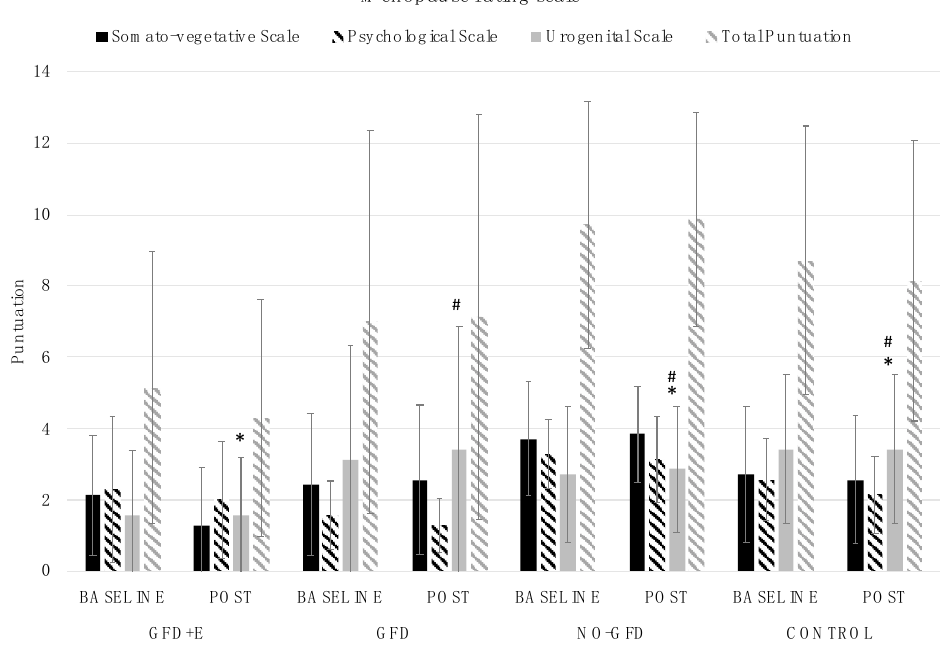
Figure 3. Descriptive statistics (mean ± standard deviation) of the Menopause Rating Scale: * differences between groups 1 (GFD+E), 3 (NO-GFD), and 4 (CONTROL); # differences between groups 2 (GFD), 3 (NO-GFD), and 4 (CONTROL); GFD + E, celiac women with a nutritional plan and physical exercise; GDF, celiac women with a nutritional plan; NO-GFD, celiac women with no nutritional plan or physical exercise; control, healthy women without diet or physical exercise intervention.